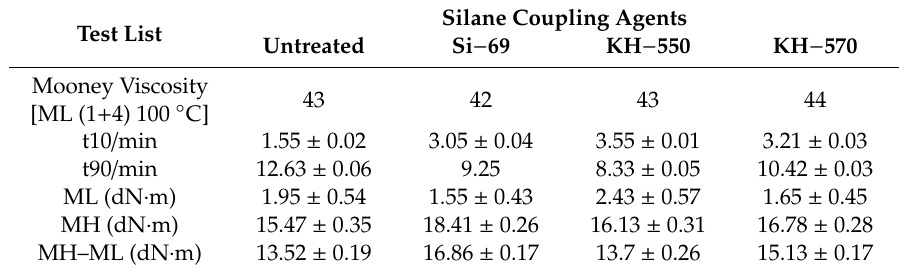
Table 3. E ff ect of di ff erent silane coupling agents on the properties of mixed